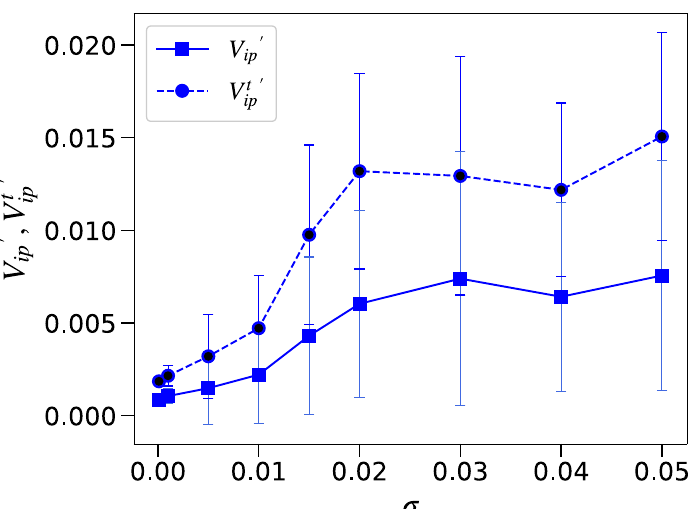
0 with noise strength. Dependence of the average variances V 0 Fig 6. Transition of V t ip 0 for target genes (dotted lines) due to noise-induced switches plotted against the noise level σ for a strong host– and V t ip parasite interaction ( c = 3). We used the function z z i . Bars represent standard